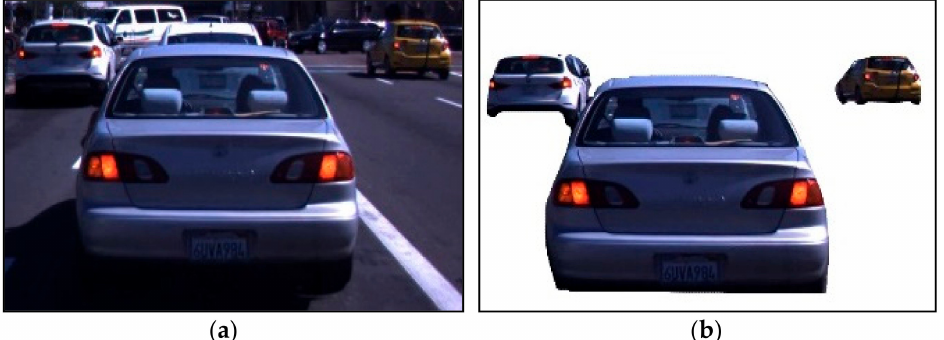
Figure 3. Example results of preprocessing: ( a ) denoised image and ( b ) background-subtracted image.